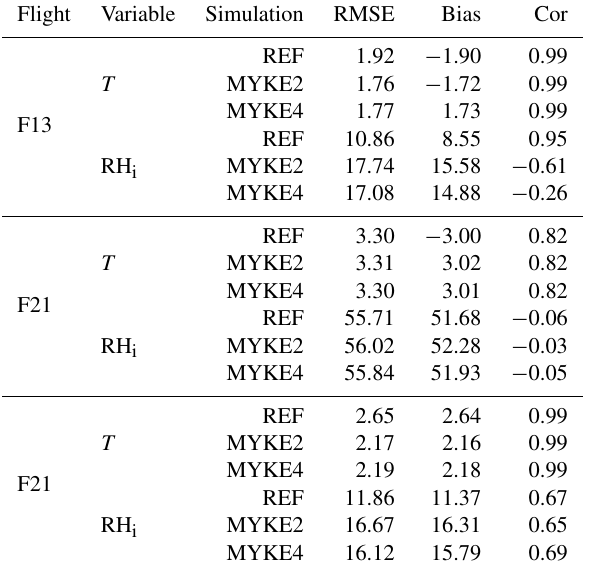
Table 4. Root mean square error (RMSE), bias (Bias) and Pearson correlation coefficients (Cor) of the temperature ( T ) and relative humidity over ice (RH i ) for the three simulations (REF, MYKE2 and MYKE4).